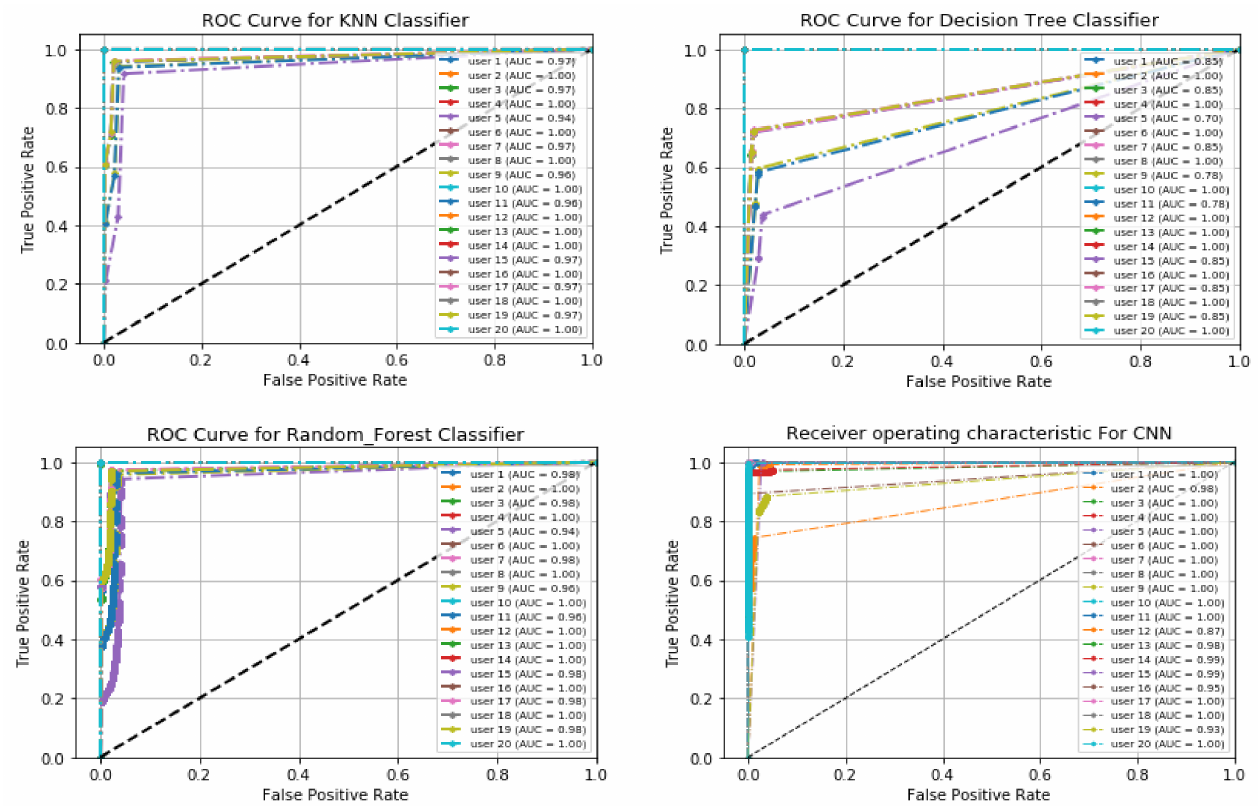
Figure 15. ROC curves for anomaly detection—single mouse movement action.